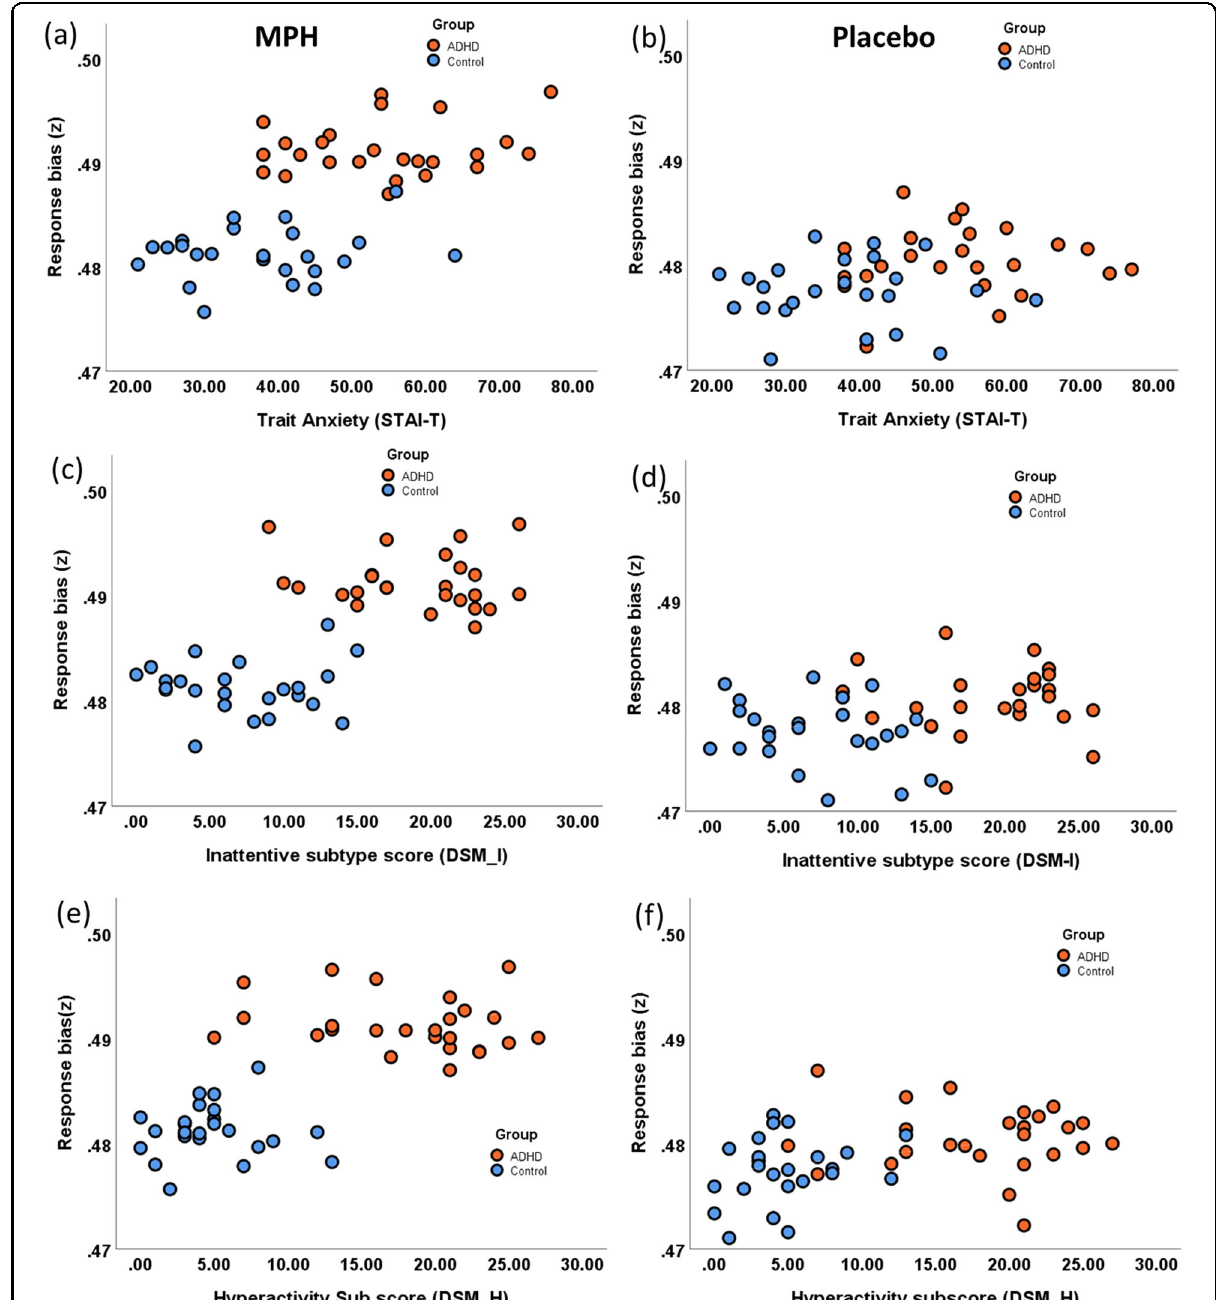
Fig. 3 Relationship between clinical scores and the response bias ( z ) parameter of the hierarchical drift diffusion model. Shows the scatter plot between response bias (z) and anxiety, inattention and hyperactivity scores in methylphenidate and placebo conditions in patient (orange) and healthy control (blue) groups ( a ) and ( b ) show the correlation between the anxiety score (STAI-trait) and response bias in placebo and drug respectively. c , d correlation between response bias and clinical inattention sub-type score (DSM-I) and ( e ) and ( f ) correlation between response bias and clinical hyperactivity sub-type score (DSM-H) in placebo and drug